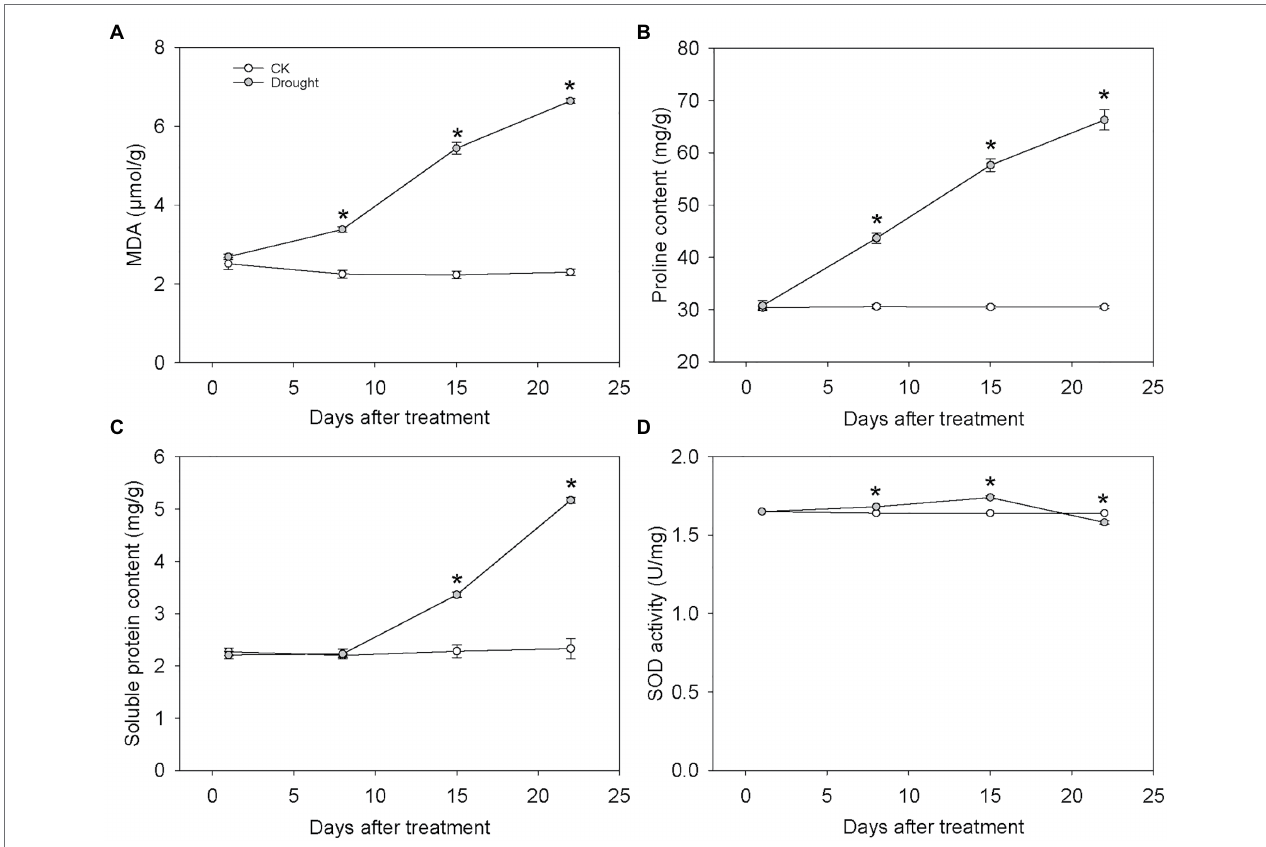
FIGURE 2 | The MDA content, Proline content, Soluble protein content and SOD activity of C. breviculmis . (A) MDA. (B) Proline. (C) Soluble protein. (D) SOD activity. Asterisk (*) denotes a significant difference at p < 0.05. Vertical bars indicate standard error ( n =